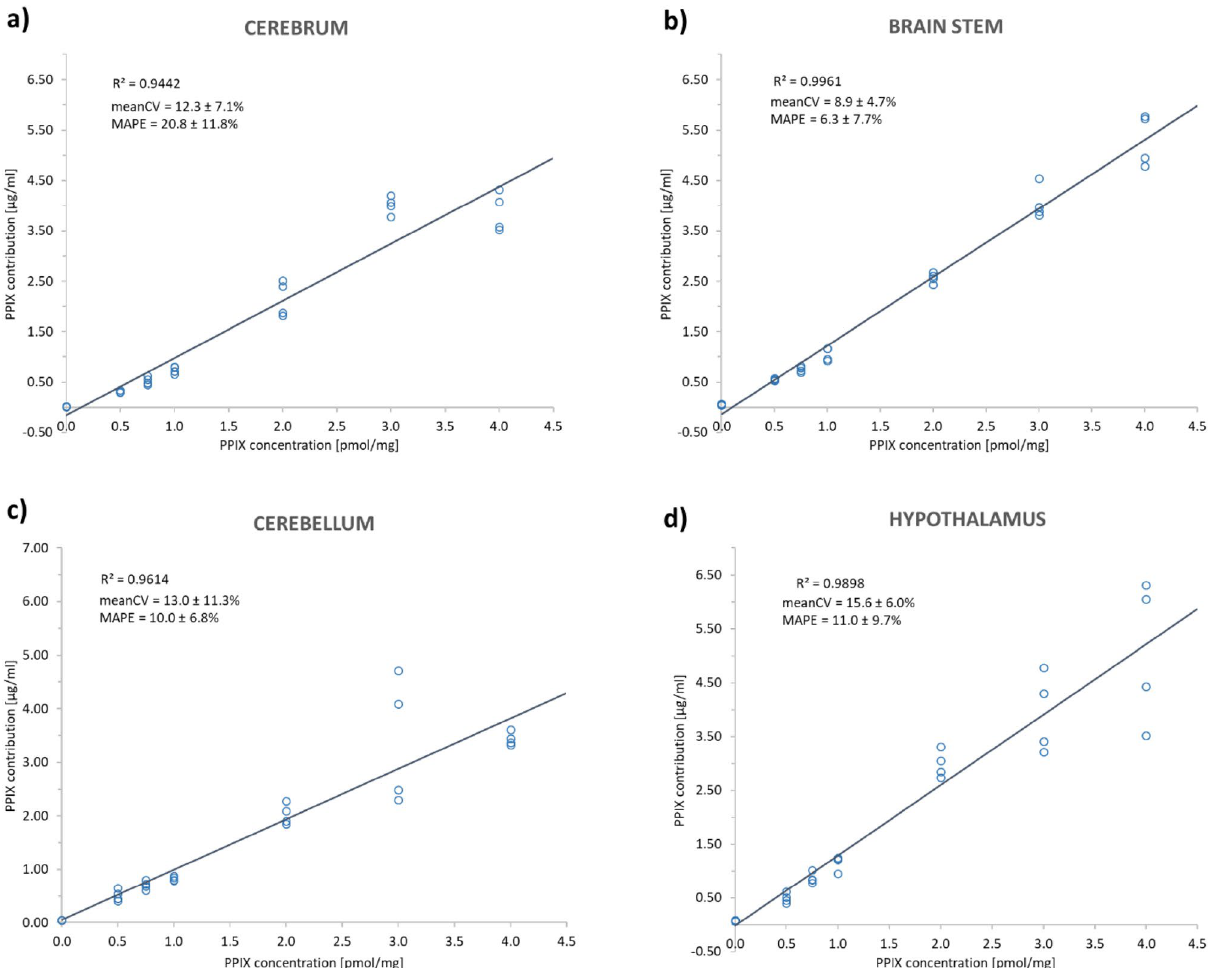
Figure 3. Results for the correlation of hyperspectrally measured PPIX contributions [µg/ml] with known PPIX concentrations [pmol/mg] in pig brain homogenates (CV = coefficient of variation, MAPE = mean absolute percentage error, mean ± standard deviation). Homogenates were prepared from ( a ) cerebrum, ( b ) brain stem, ( c ) cerebellum and ( d ) hypothalamus to accommodate variations of tissue optical properties. PPIX was spiked in known concentrations: 0.0, 0.5, 0.75, 1.0, 2.0, 3.0 and 4.0 pmol/mg with n = 4 replicates.